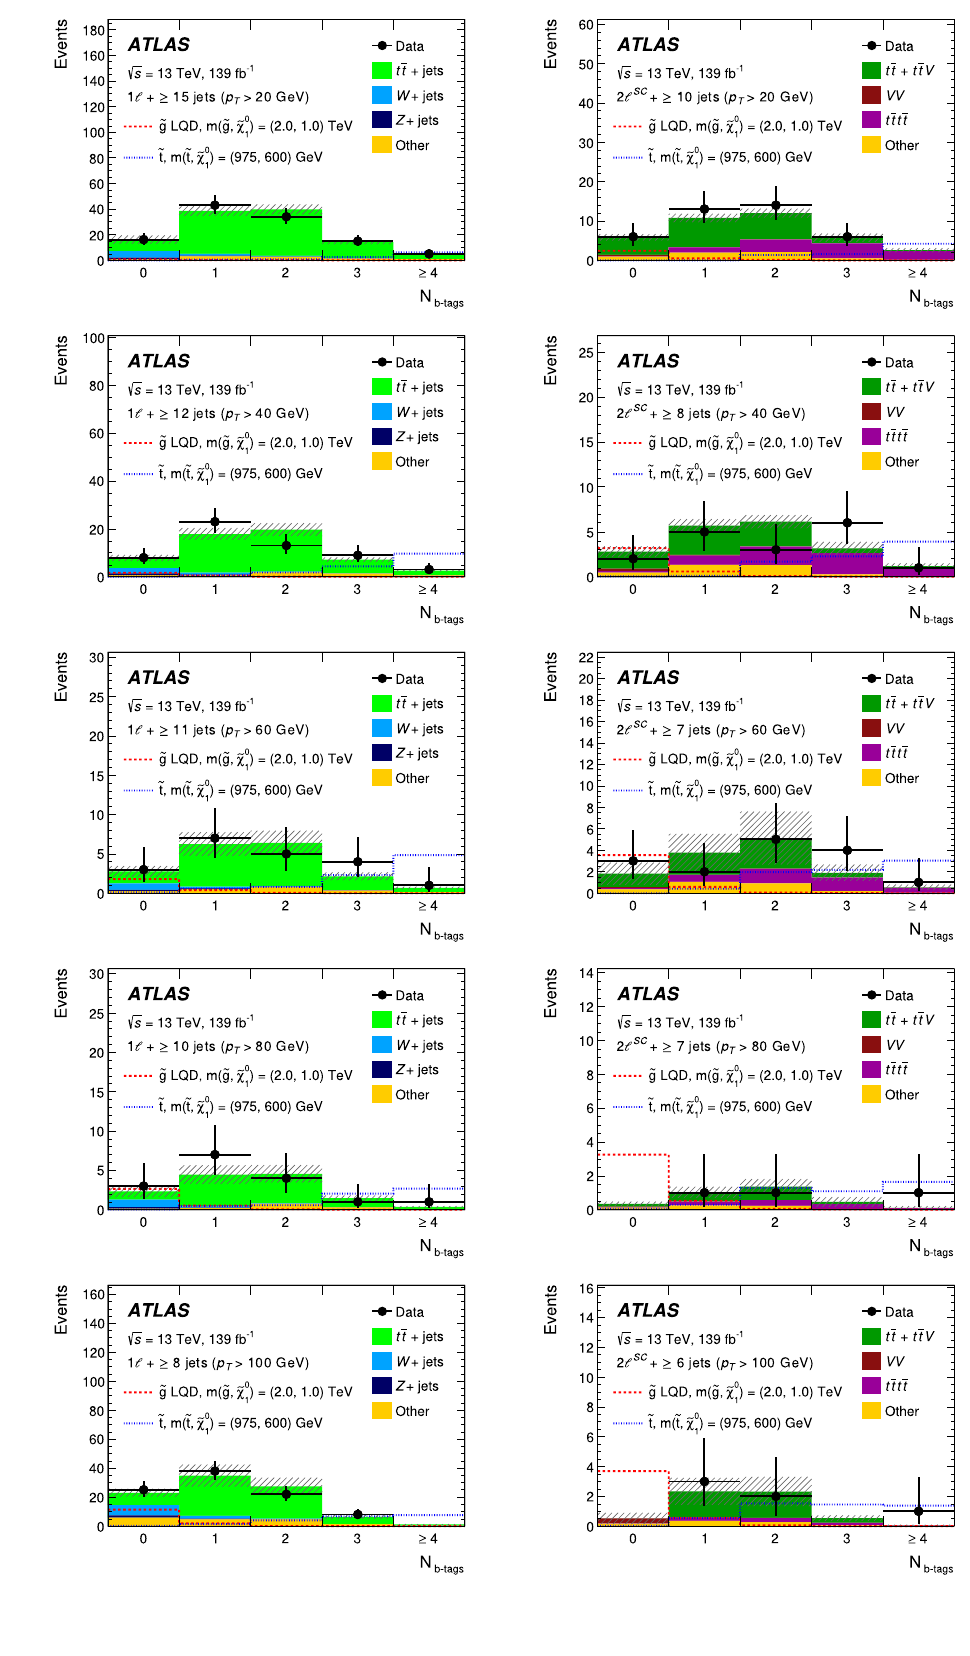
Fig. 8 The observed data event yields and the corresponding estimates for the backgrounds in the different last jet-multiplicity bins defined for the 1 (cid:3) (left) and 2 (cid:3) sc (right) categories. The background shown is estimated by including all bins in the fit. All uncertainties, which may be correlated across the bins, are included in the error bands (shaded regions). Hypothetical contributions from representative RPV SUSY scenarios are displayed as dashed and dotted